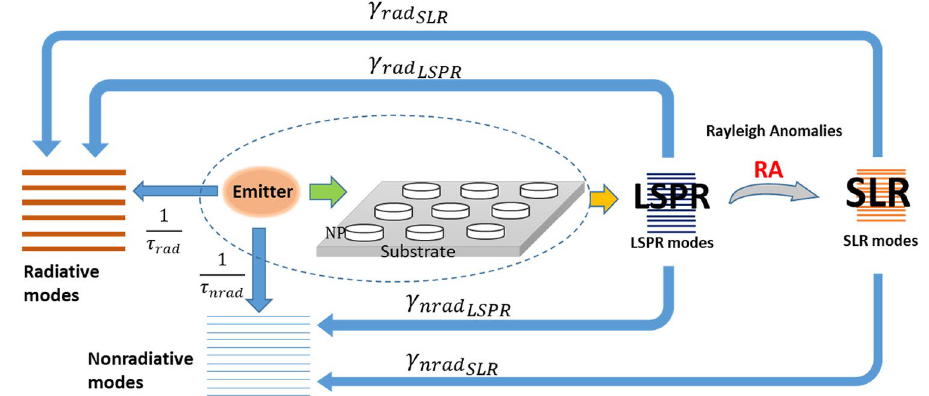
Figure 8. Illustration of the coupling between an emitter and a periodic grating of metallic NPs. Two mechanisms occur due to the presence of the LSPR and SLR connected by the Rayleigh